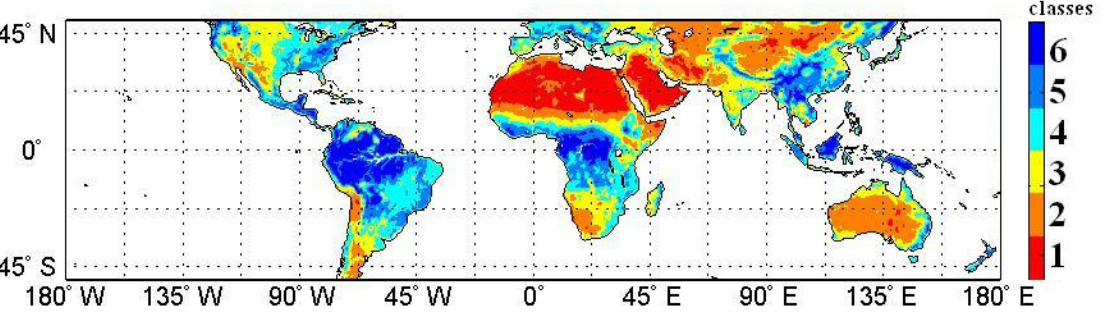
Fig. 3. Vegetation classes, of which the boundaries are indicated in Table 1, over which the R value method and the TC method were evaluated based on the simultaneously derived average vegetation optical depth ( τ) of the AMSR-E descending overpass for the period February 2003 till December 2010.